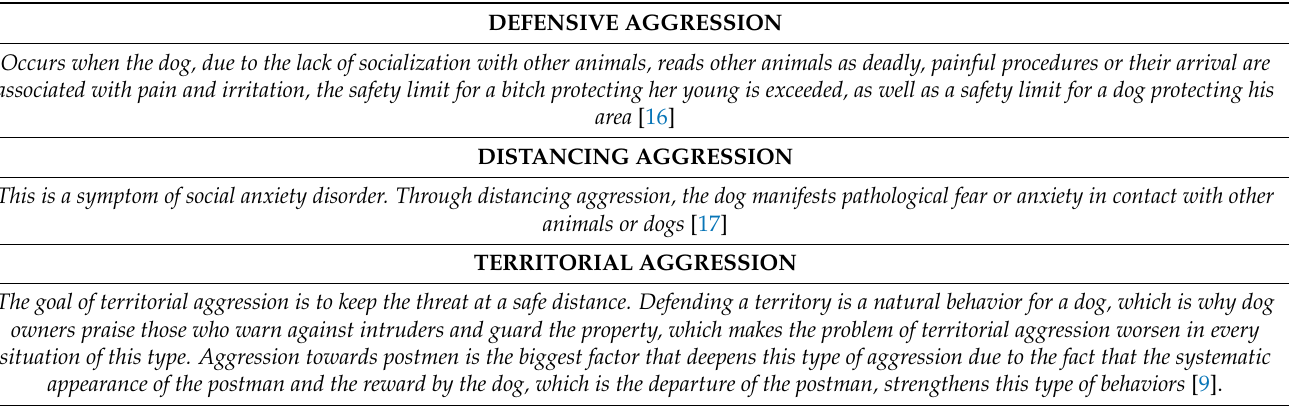
Table 1. Selected aggression behavior